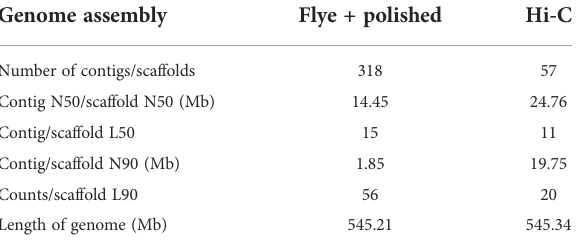
TABLE 2 Verasper variegatus genome assembly